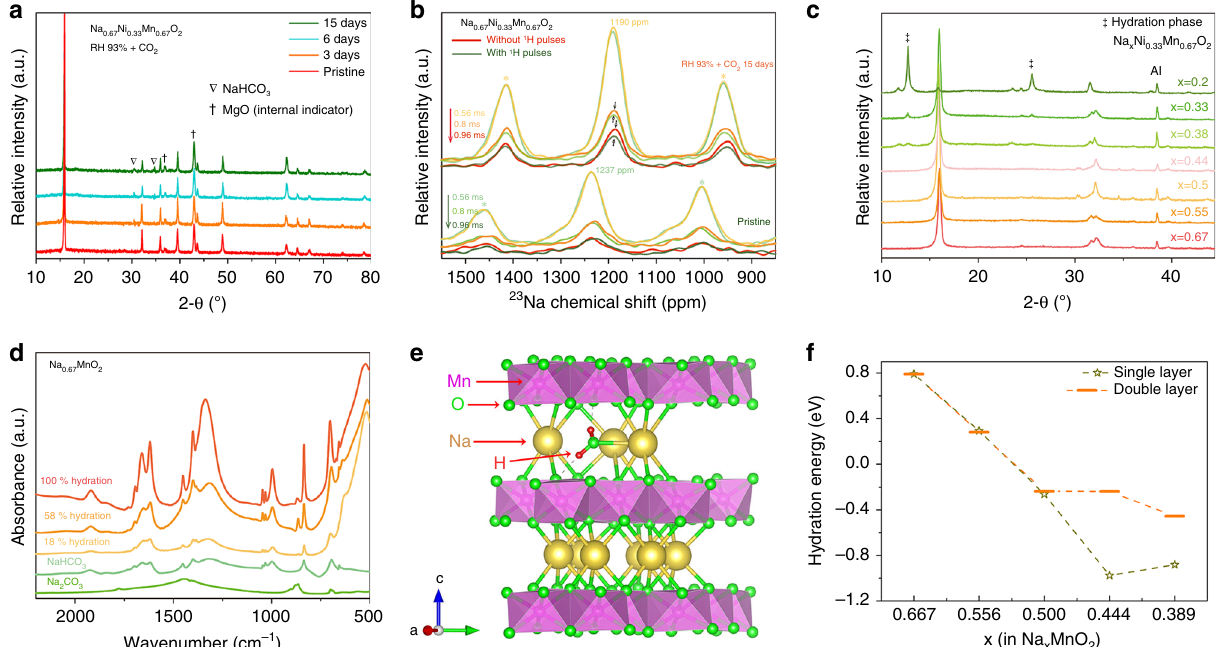
Fig. 4 The structural and chemical evolution mechanisms upon air-exposure. a The XRD evolutions of Na 0.67 Ni 0.33 Mn 0.67 O 2 powder exposed at RH 93% + CO 23 Na{ 1 H} REDOR-dephased 23 Na MAS NMR spectra (MAS rate: 25 kHz) 2 atmosphere for different times (MgO was used as internal indicator). b and c The XRD patterns of exposed Na x Ni 0.33 Mn 0.67 O 2 electrodes with various Na + content x. d The FTIR spectra of Na 0.67 MnO 2 samples with various hydration degrees. e The structure model of single layer Na + loss structure for calculating hydration energies. f The calculated hydration energies for Na x MnO 2 at various sodium contents